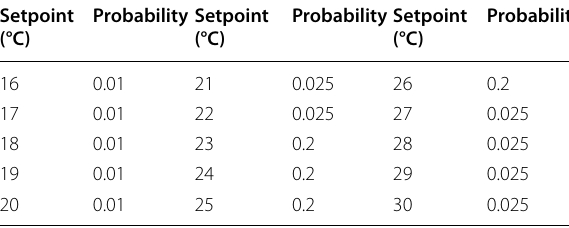
Table 6 Probability law for customer thermostat setpoints Setpoint (°C)